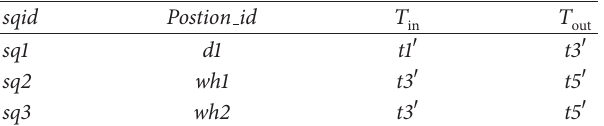
Table 3: Storing for uncertain data.